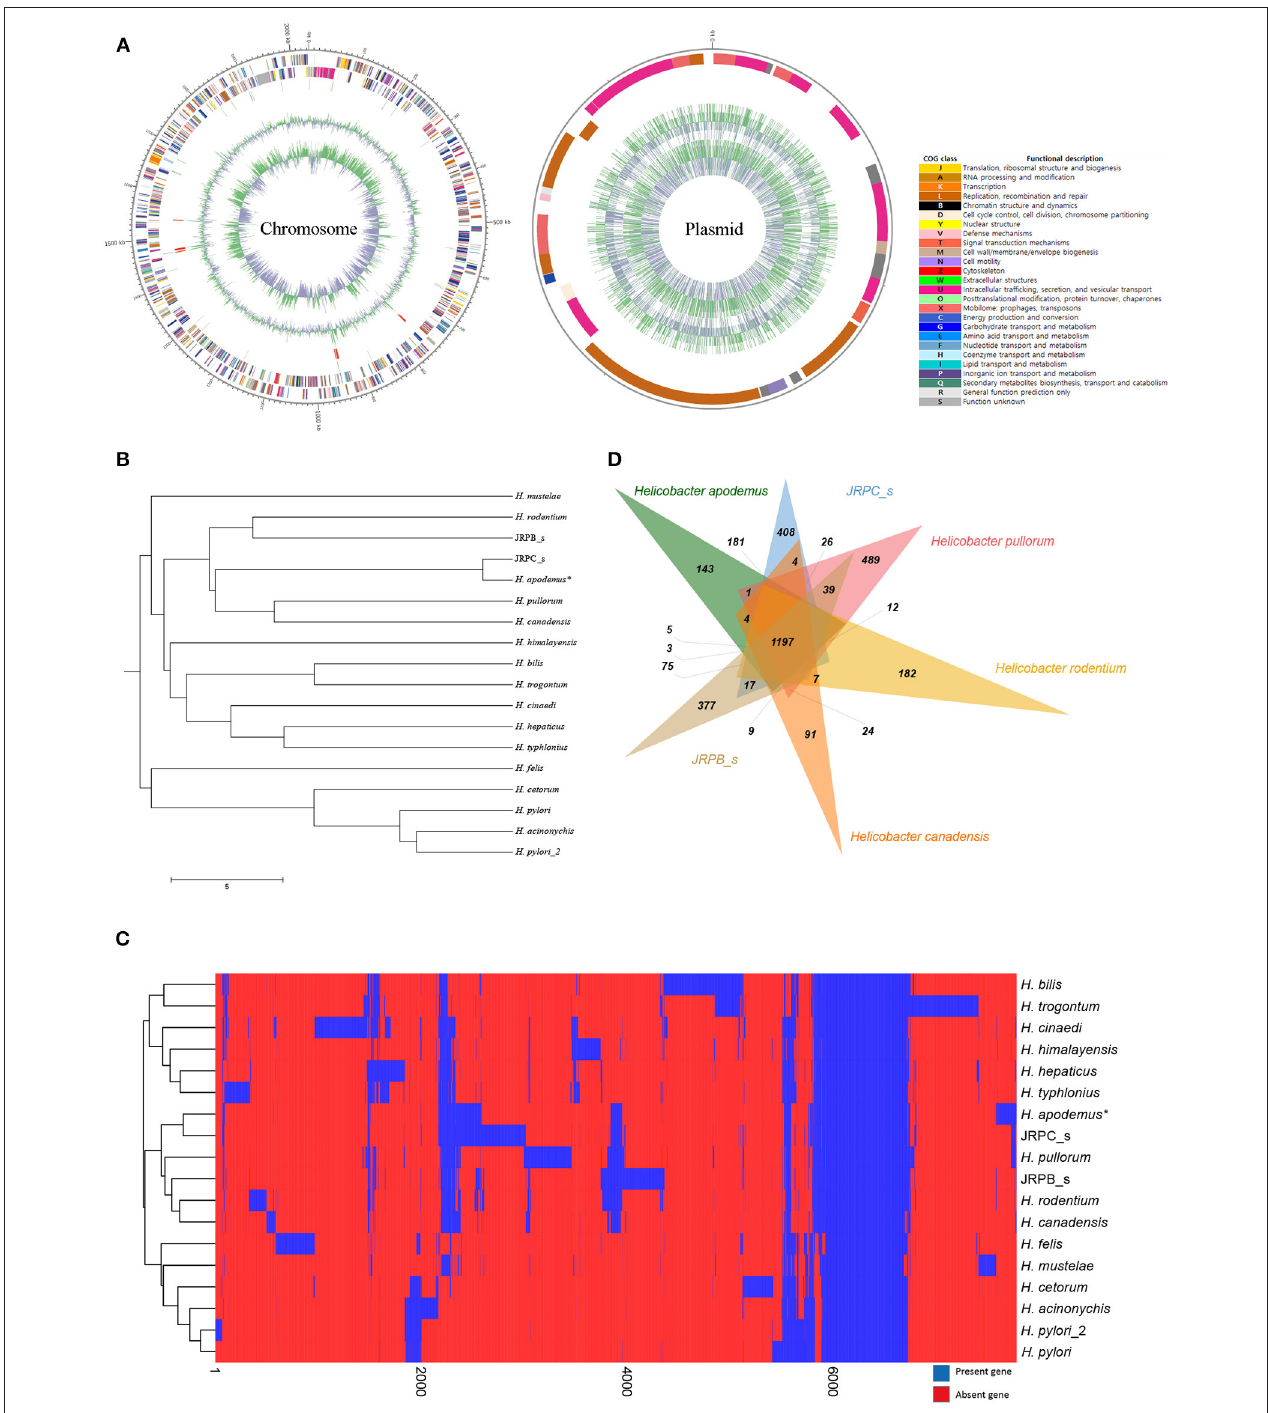
FIGURE 1 | Complete genome sequence and comparative genomic analysis of Helicobacter apodemus str. SCJK1 with respect to 17 other Helicobacter spp. (A) Circular map of the H. apodemus str. SCJK1 genome, and Clusters of Orthologous Group (COG) categories within the genome, assigned using the NCBI COGs database. (B) Unweighted Pair Group Method with Arithmetic Mean (UPGMA) dendrogram of the analyzed Helicobacter spp. based on the orthologous Average Nucleotide Identity (Ortho ANI) value. (C) Heat map and UPGMA dendrogram of the analyzed Helicobacter spp. based on the presence or absence of Pan-genome Orthologous Groups (POG). (D) Venn diagram of six-clustered Helicobacter spp. based on POG analysis. * H. apodemus str. SCJK1 genome used in the current study.